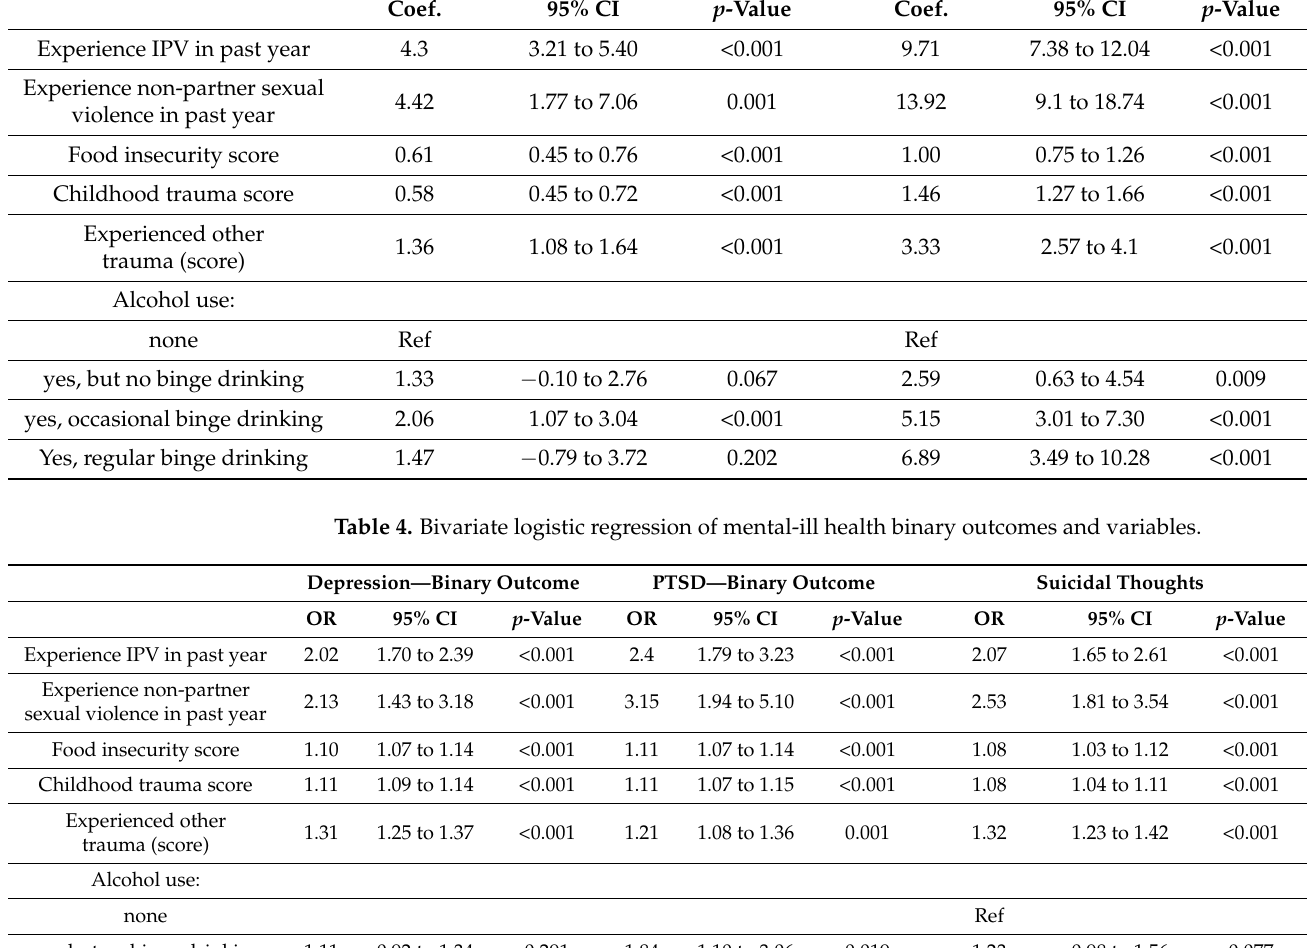
Table 3. Bivariate linear regression of mental-ill health score outcomes and variables. Depression Score Outcome PTSD Score Outcome Coef. 95% CI p -Value Coef. 95% CI